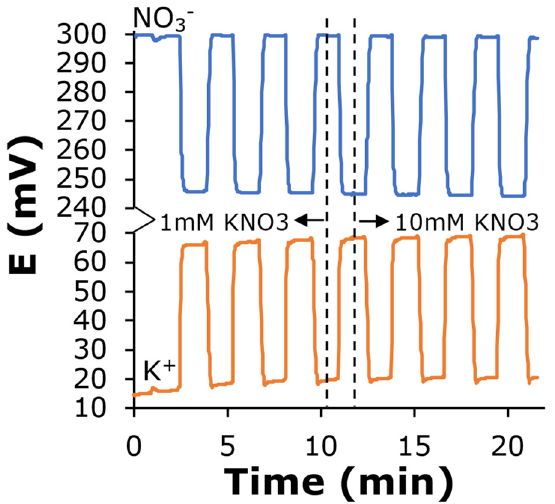
Figure 6. Automated two-point calibration. Potentials were recorded for 1 min at stopped-flow and then the channel was rinsed with a new solution for 25 s. Electrolyte: KNO 3 + 10 mM NaCl. Reference: electroplated Ag/AgCl.